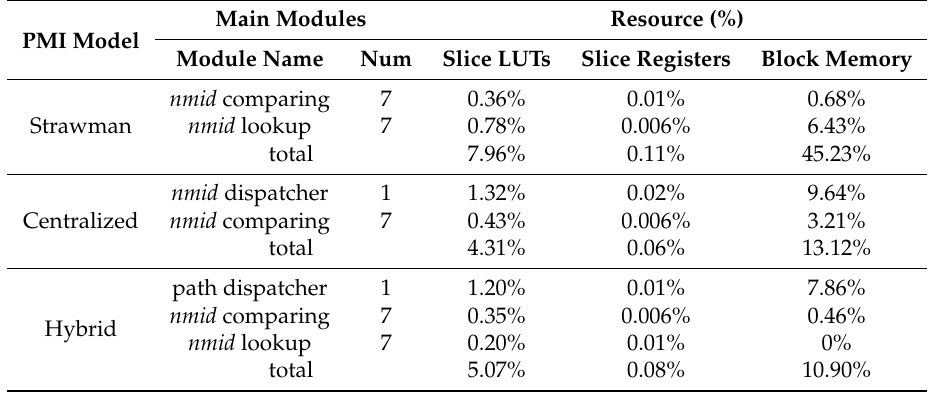
Table 3. The resource utilization of three PMI models, i.e., strawman, centralized and hybrid, when constructing four module chains (outlined in Figure 9) for 1K